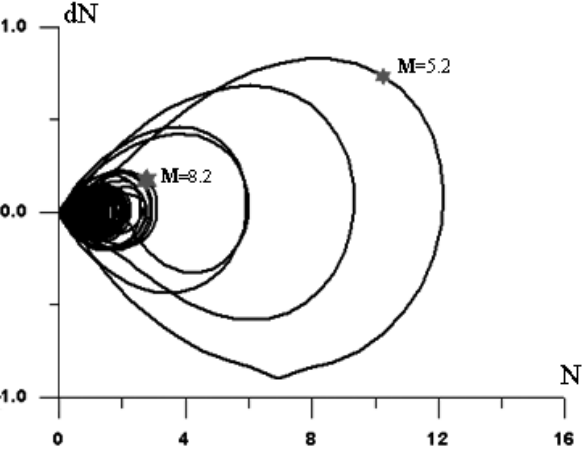
Fig. 10. Phase portrait of seismicity within a radius of 100km from the epicenter of the Simushirskoe earthquake for a 44-year period (1 January 1962–15 November 2005). The smoothed number N of earthquakes for 10 consecutive days is marked on the X axis. Rates at which these parameters change, i.e. the difference between the following and the preceding values are shown on the Y axis. The clockwise movement along the curve corresponds to an increase in time. The stars mark the positions of the main shock ( M = 8 . 2) and foreshock ( M = 5 . 2).